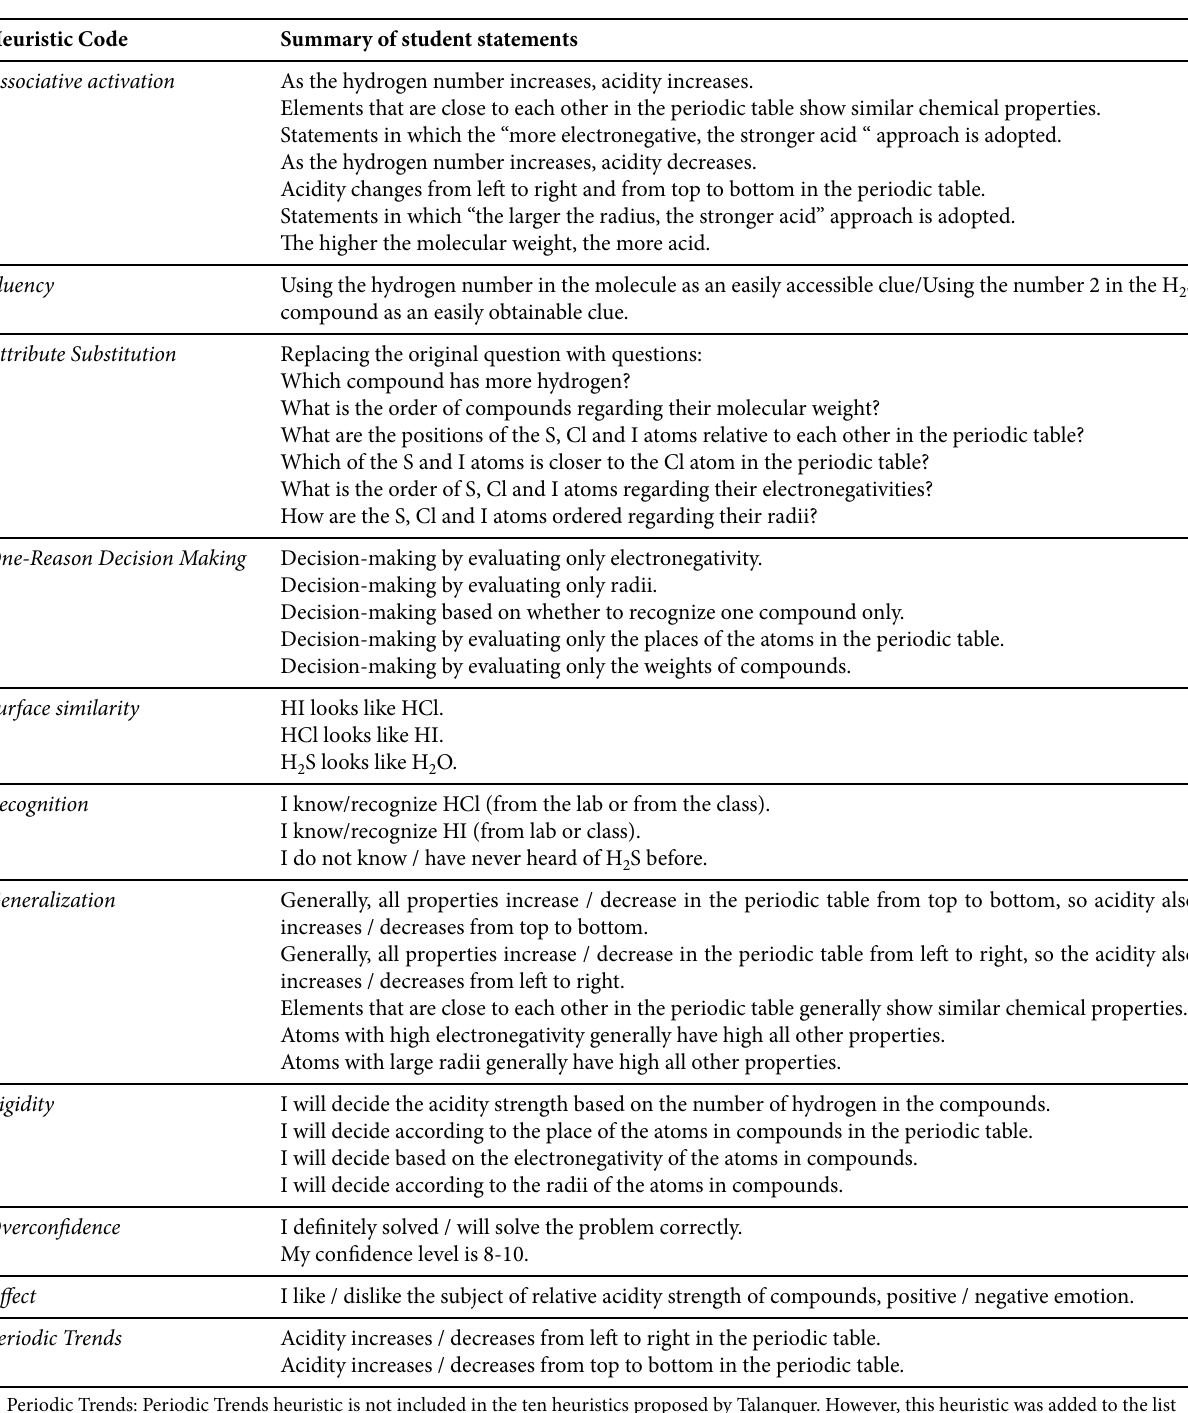
Table 2. Student Expressions Related to Heuristics (Acidity strength, HCl, H 2 S and